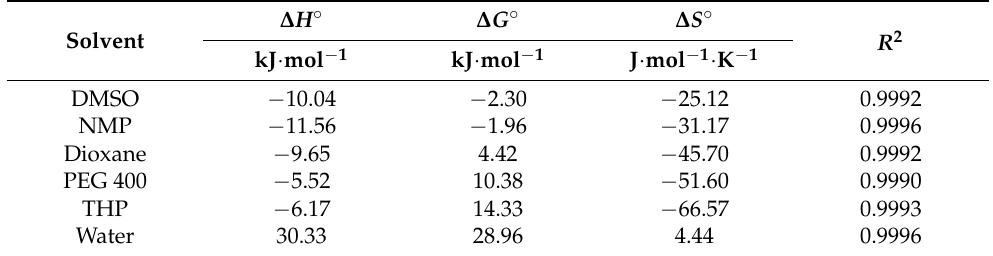
Table 9. Apparent thermodynamic parameters for the dissolution behavior of GLN in different solvents.